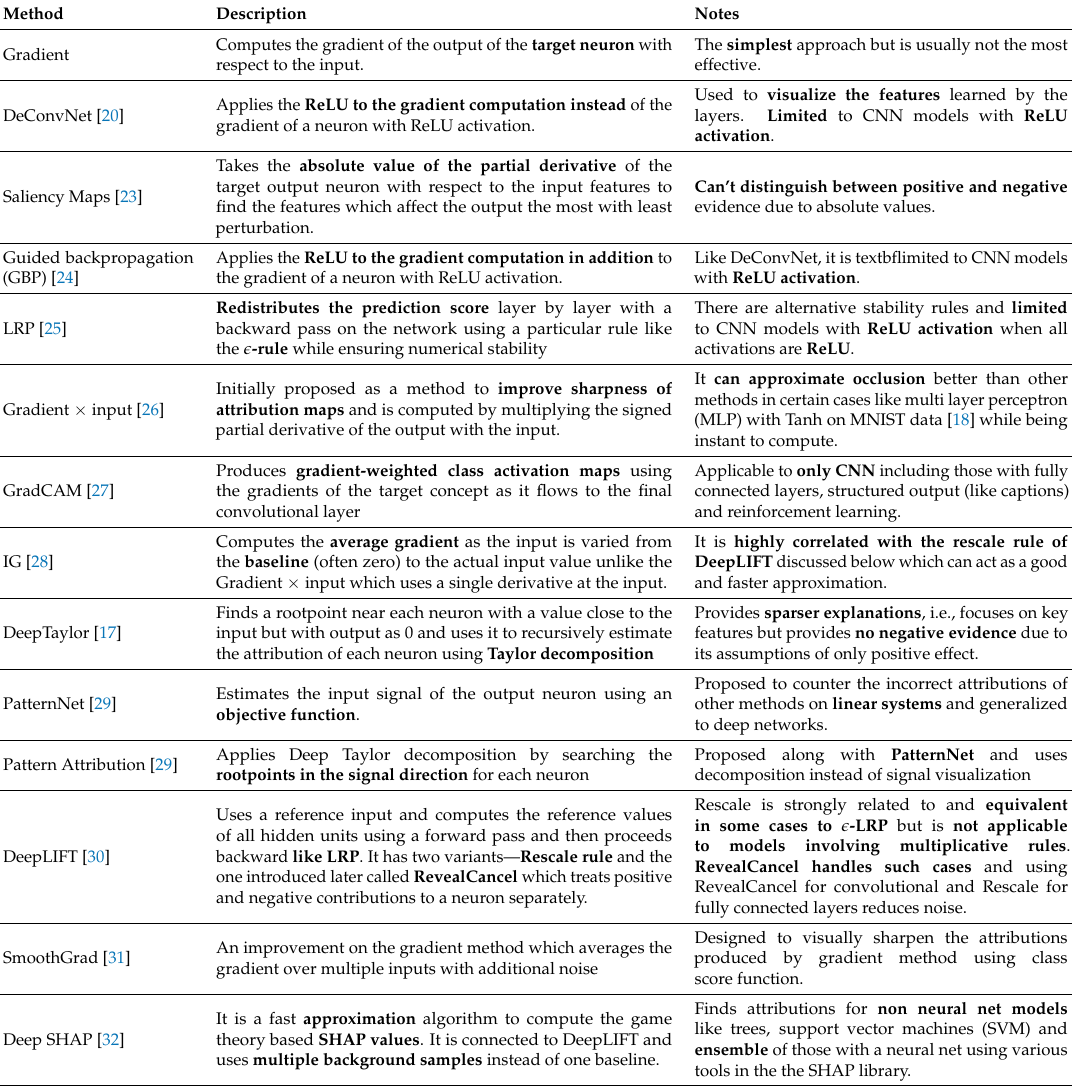
Table 1. Backpropagation based attribution